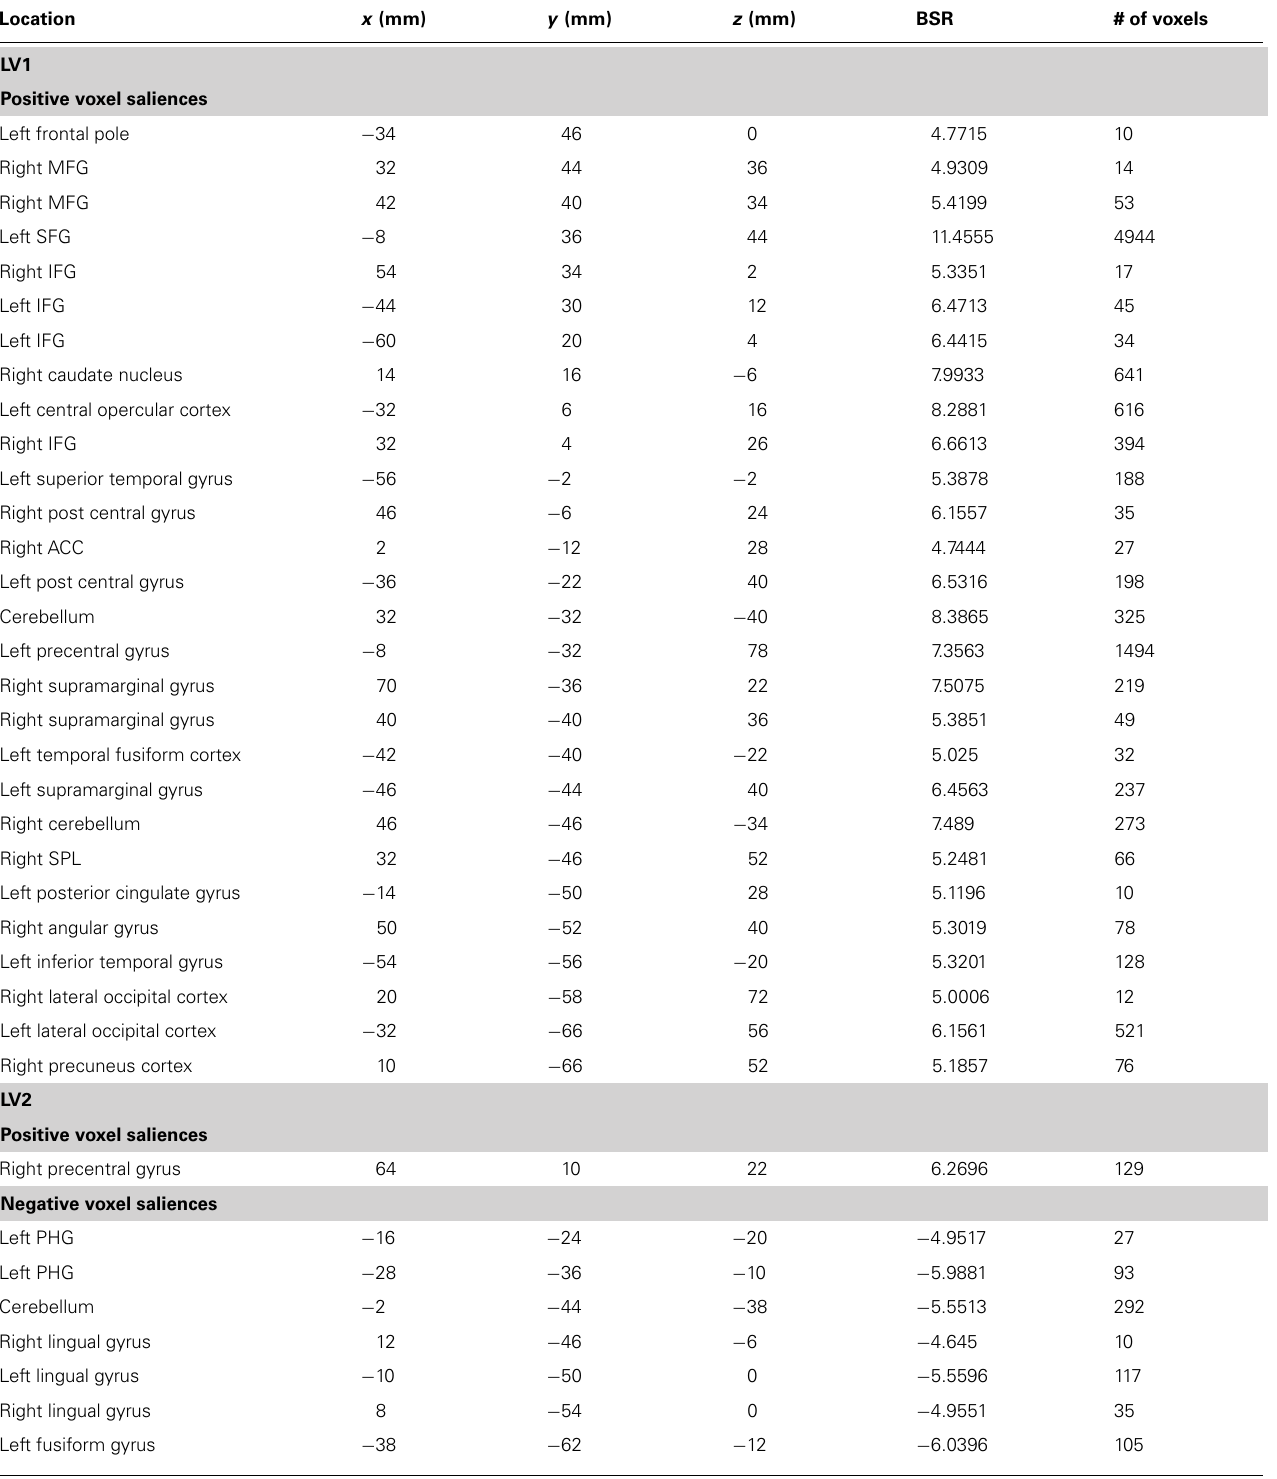
Table 2 | Cluster peaks showing brain regions where increased BOLD activity was associated with path integration accuracy for LV1 ( p < 0.001) and LV2 ( p <